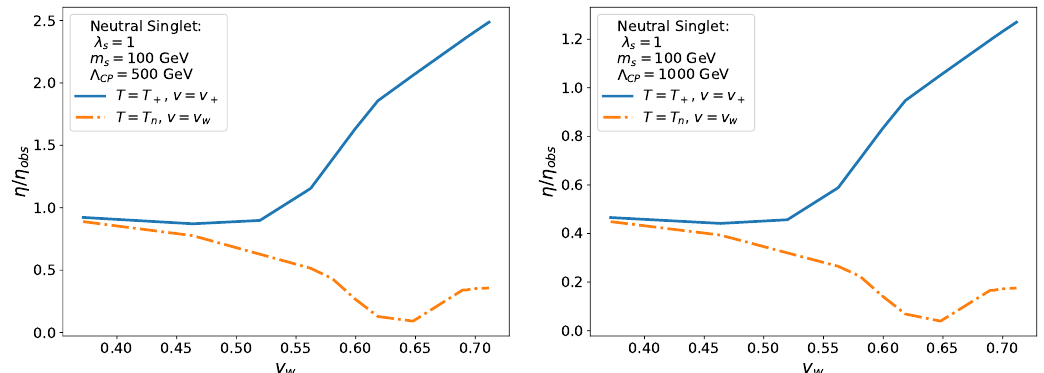
, v (blue solid) and using the naive variables T + +